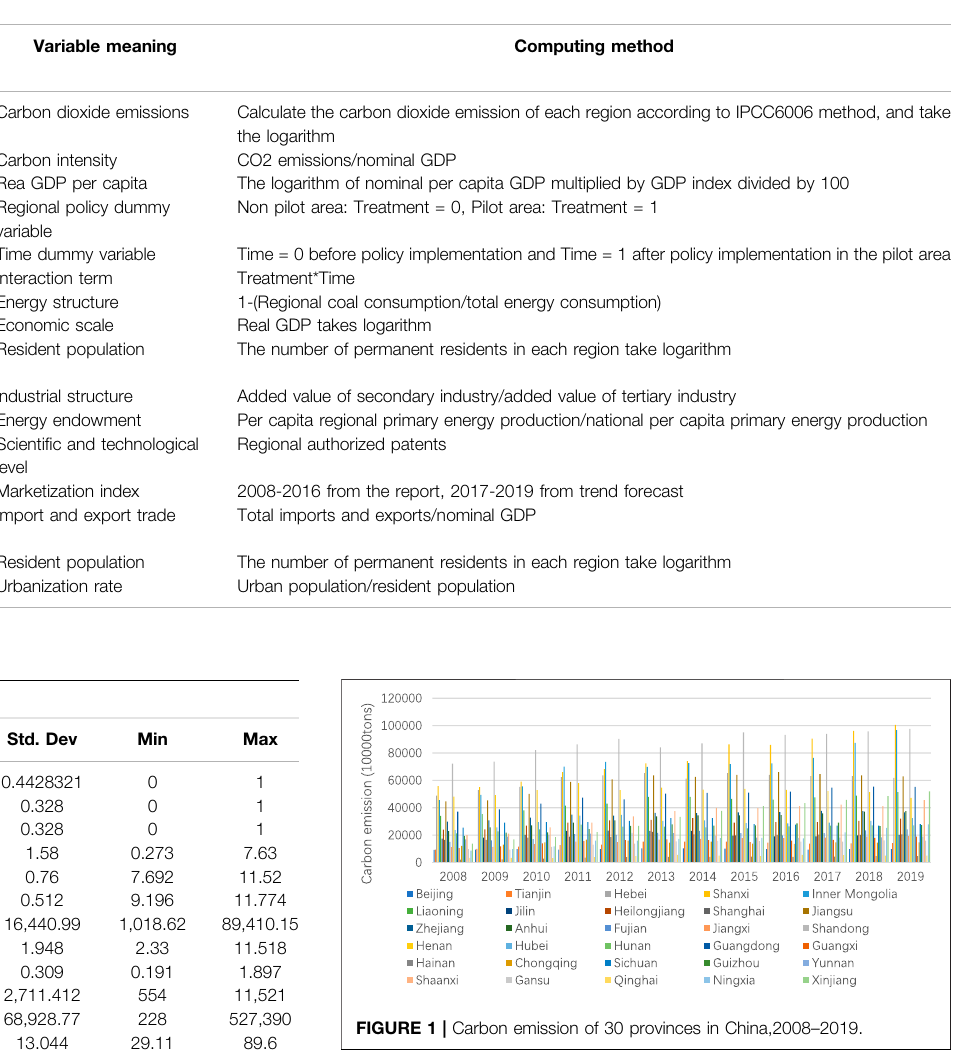
TABLE 1 | Variables.